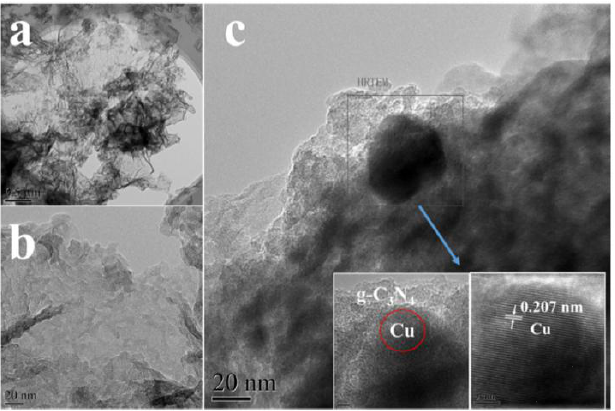
Figure 9. TEM images of g-C 3 N 4 at low ( a ) and high ( b ) magnification and TEM image of Cu